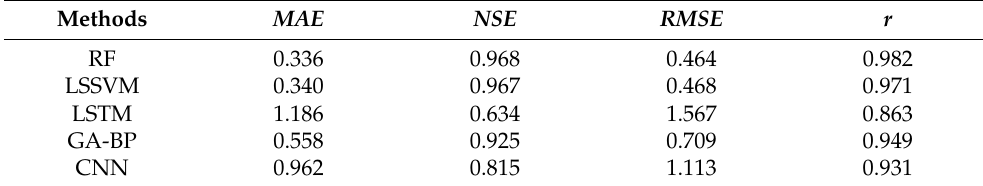
Table 3. Statistics of fitting results for five machine learning